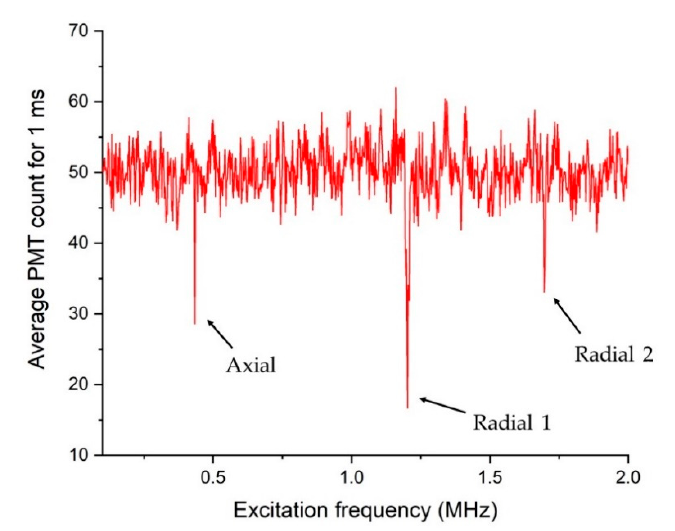
Figure 9. The number of photons emitted by trapped ions as a function of excitation frequency.